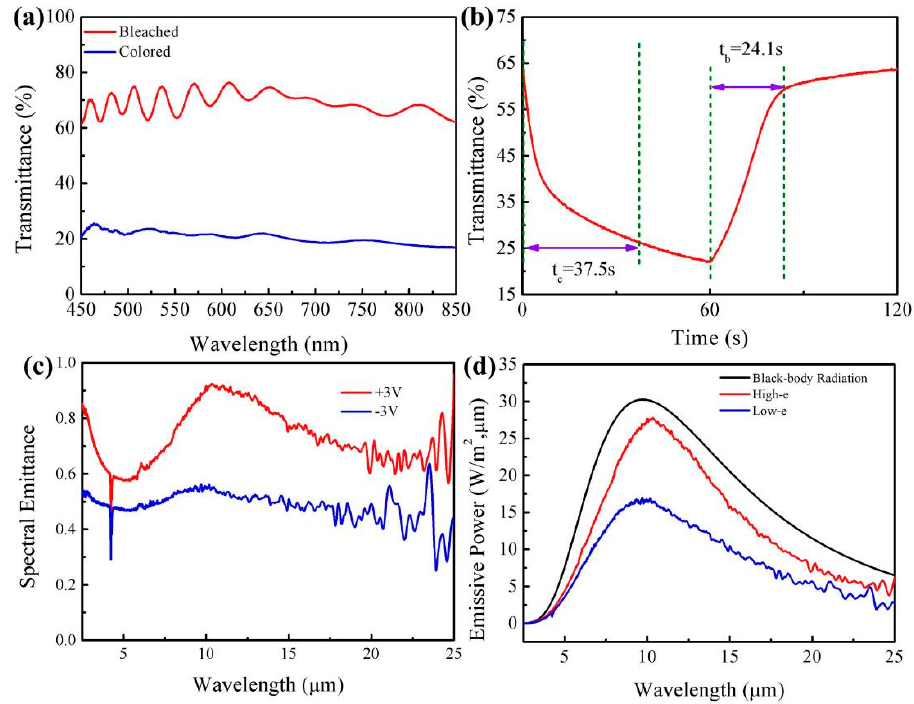
Figure 6. ( a ) Transmittance spectra, ( b ) Time-dependent transmittance spectra, ( c ) Spectral emittance curves, and ( d ) Emissive power curves of the ECD with W-NiO after 150 cycles.